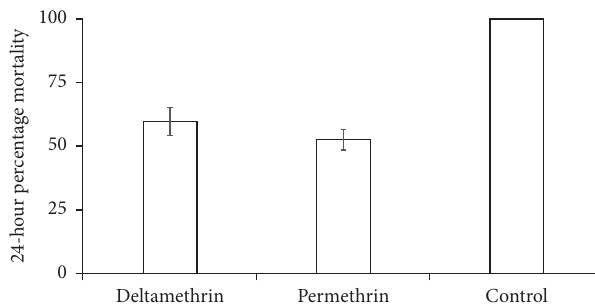
Figure 3: Mortality of wild Anopheles gambiae s.l. exposed to different treatments (i.e., deltamethrin, permethrin, and control) (single factor ANOVA, P � 0 . 001).